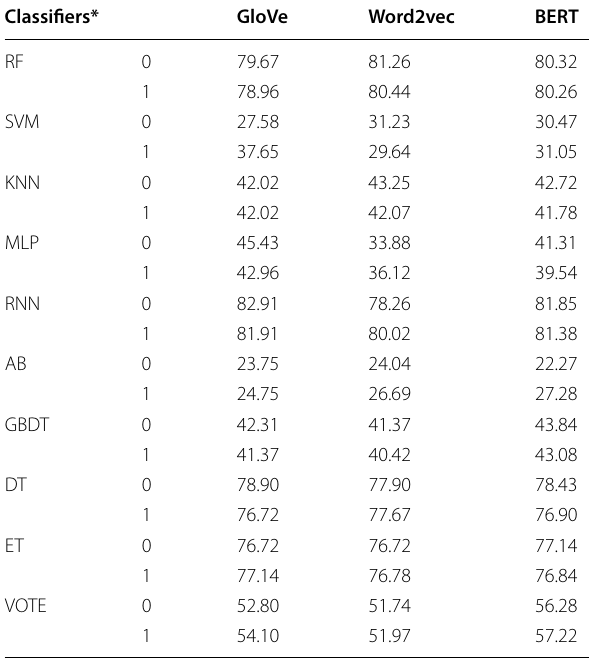
Table 13 The accuracy result with and without imbalance learning (%)